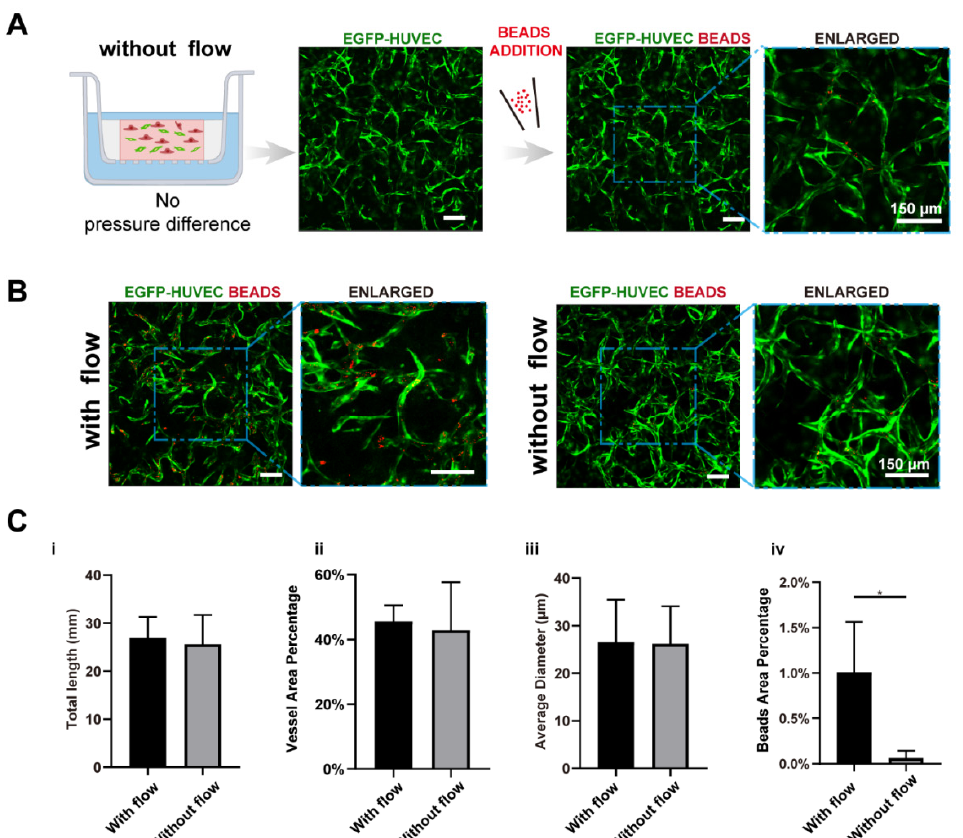
Figure 3. Interstitial flow enhanced the perfusability of the vasculatures in the presence of fibroblasts. ( A ) Confocal images of constructed vasculatures with NHLFs, but without flow. The constructed vessels were perfused with red beads to characterize the perfusability. Scale bar: 150 µ m. ( B ) The representative confocal images of vasculatures developed with/without flow. Scale bar: 150 µ m. ( C ) The analyzed morphological statistics of the vessels, including total length ( i ), vessel area percent- age ( ii ), average diameter ( iii ), and the beads area percentage ( iv ) which represented the perfusability of the vasculatures. The data was presented with the average value ± standard deviation ( n = 3). p -Values were calculated using the student’s t -test. *, p <